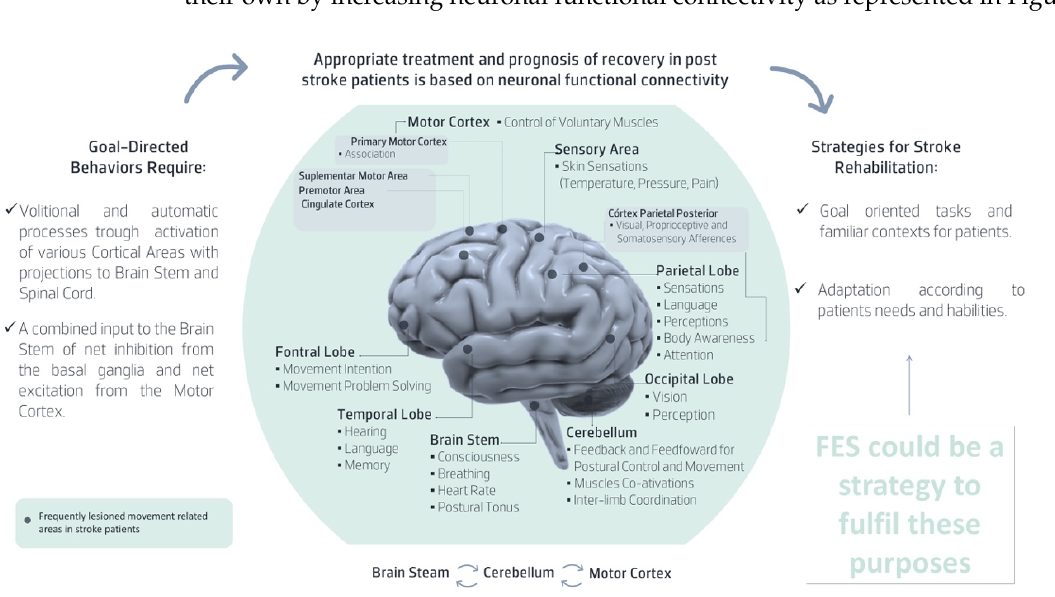
Figure 3. Demonstration on how FES could increase neuronal functional connectivity in post-stroke